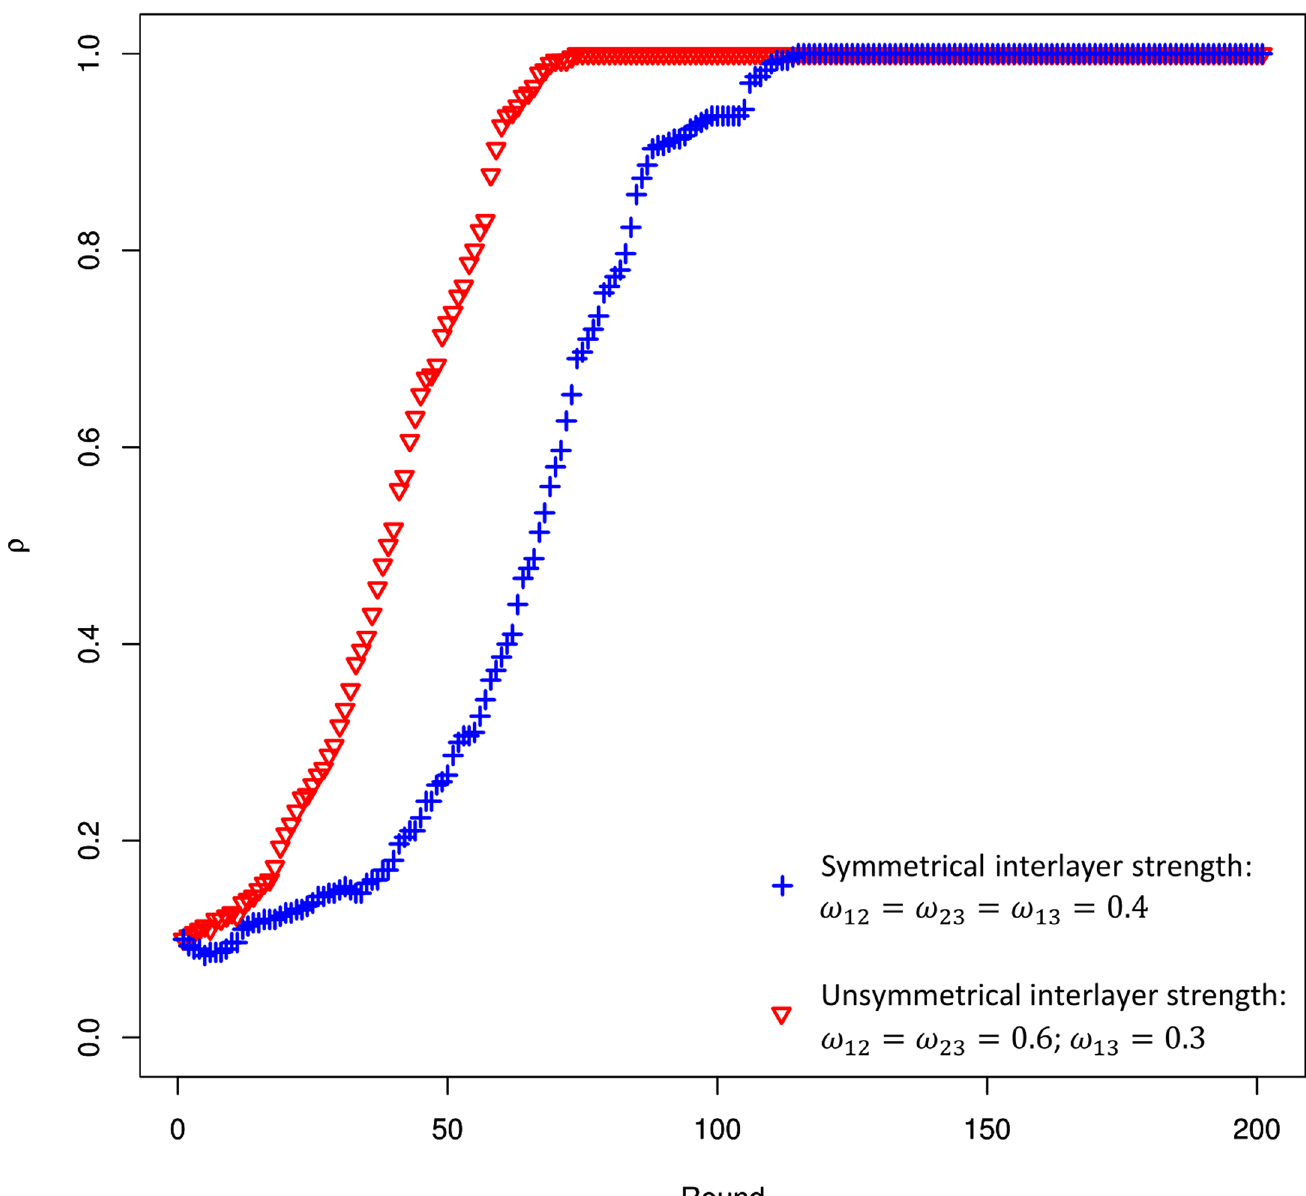
Fig 4. Evolution of cooperation considering different interlayer interaction strength. The evolution of cooperation against the round as a function of interlayer interaction strength. The ‘ blue ’ plot represents the case of constant interlayer strength: ω αβ = 0.4. The ‘ red ’ plot represents the case of variable interlayer strength (one dominant layer): ω αβ = 0.3 between layers 1 and 3; ω αβ = 0.6 between the layer 2 and the other layers of the multiplex. We show the evolution of cooperation until 200 rounds as, in correspondence of that value, the convergence has already been reached. It can be observed that the emergence of cooperation is quicker considering a variable interlayer strength (one dominant layer), than the constant case. The dominant layer acts as a behaviour ’ s polarizer of the nodes in the other